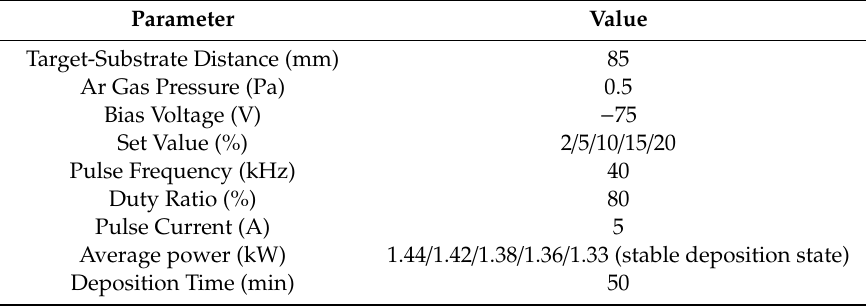
Table 1. The deposition parameters of Cr-DLC